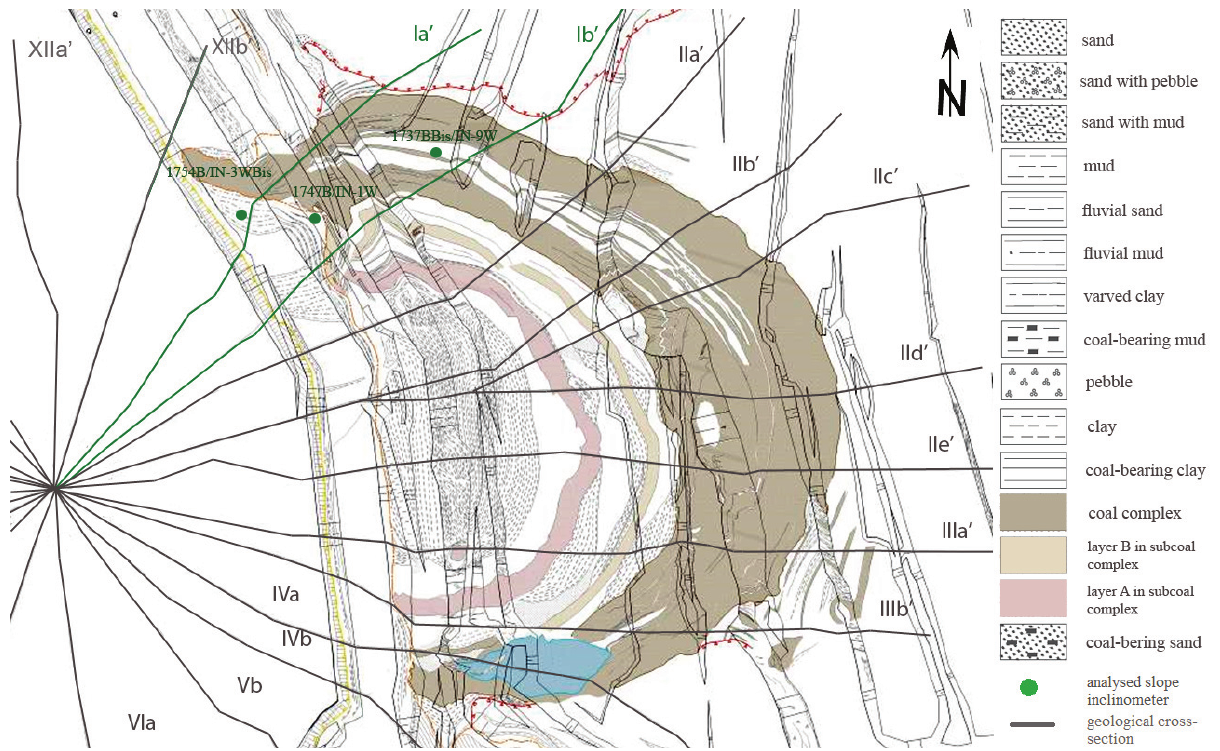
Fig. 2. The main anticline in the Bełchatów mining field (after